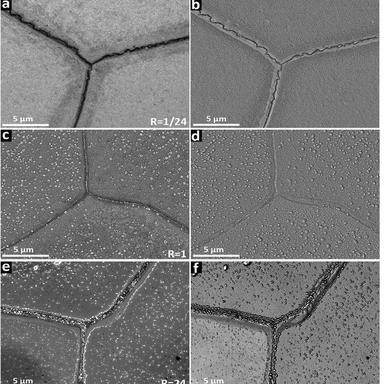
FEG-SEM observations of specimens exposed in H2-steam environment at 480 C. (a, c, e) SE and (b, d, f) BSE images representative of the specimen surfaces after 210 h exposure under different oxidizing conditions: (a, b) R ¼ 1/24; (c, b) R ¼ 1; and (e, f) R ¼ 24.